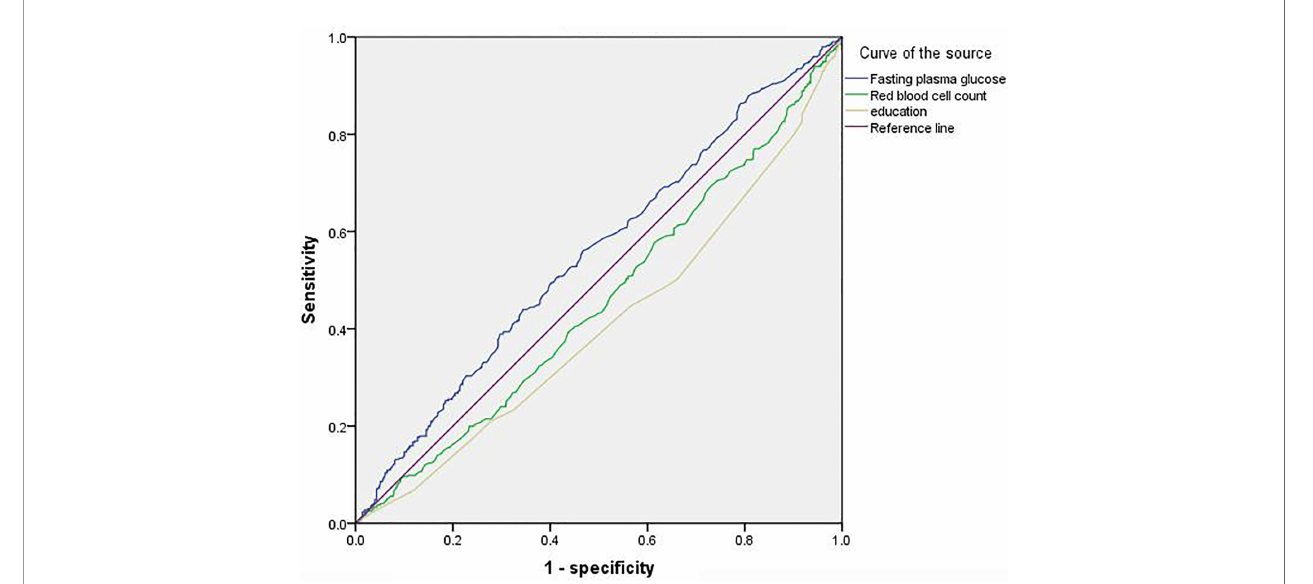
FIGURE 1 | ROC Curve.